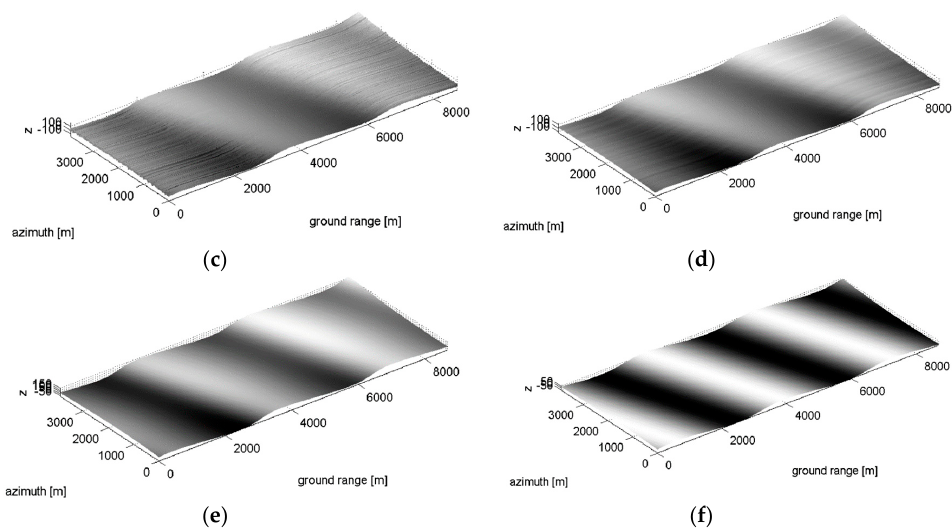
Figure 8. Output of the algorithm: speckle-free, (a) before and (b) after azimuth regularization procedure; with Rayleigh-distributed speckle, (c) before and (d) after azimuth regularization procedure; (e) assuming known starting points. (f) Original sinusoidal DEM with a mean slope of 5° projected in azimuth-slant range.